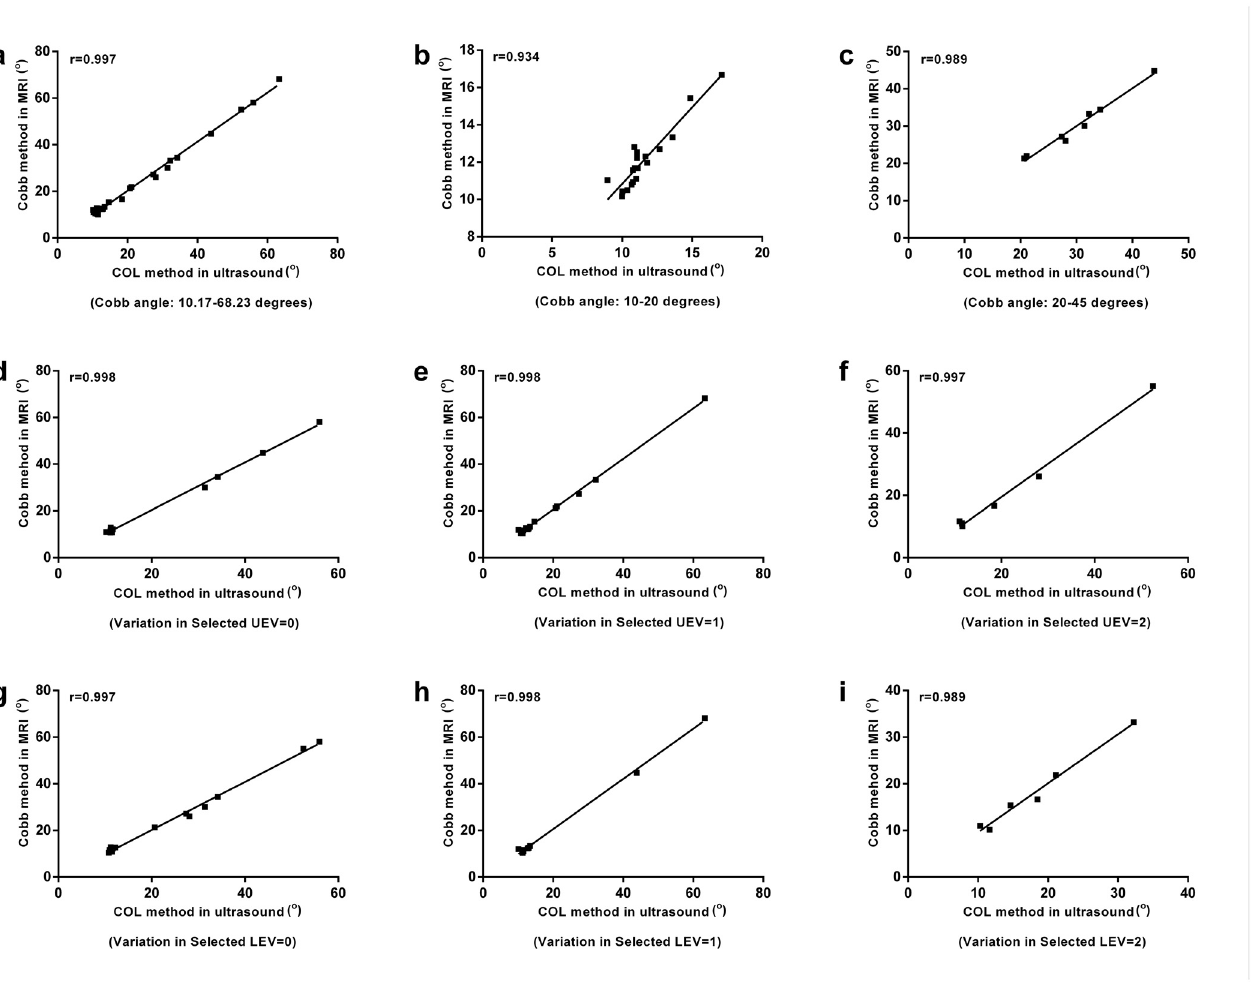
Fig 7. Correlation of coronal curvature measurements using ultrasound and MRI in the sample categories. (a) Cobb angle: 10.2°~68.2°; (b) Cobb angle: 10.0°~20.0°; (c) Cobb angle: 20.0°~45.0°; (d) Variation in selected UEV = 0; (e) Variation in selected UEV = 1; (f) Variation in selected UEV = 2; (g) Variation in selected LEV = 0; (h) Variation in selected LEV = 1; (i) Variation in selected LEV = 2. UEV: upper-end vertebra; LEV: lower-end